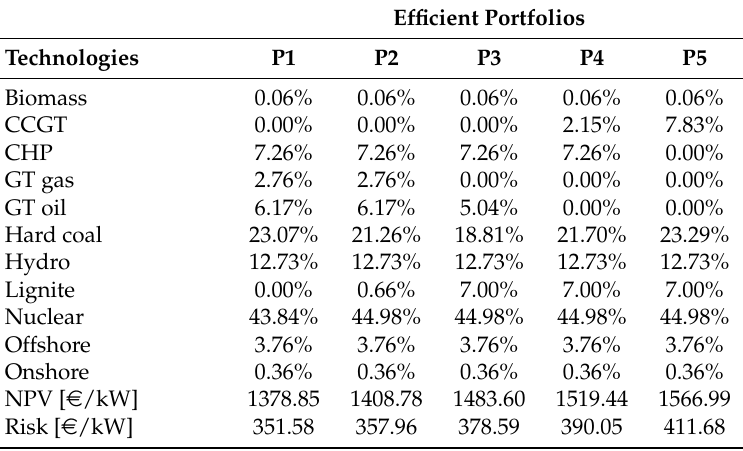
Table A6. Efficient portfolios according to FSMAD Model 3 for existing technologies combined with new